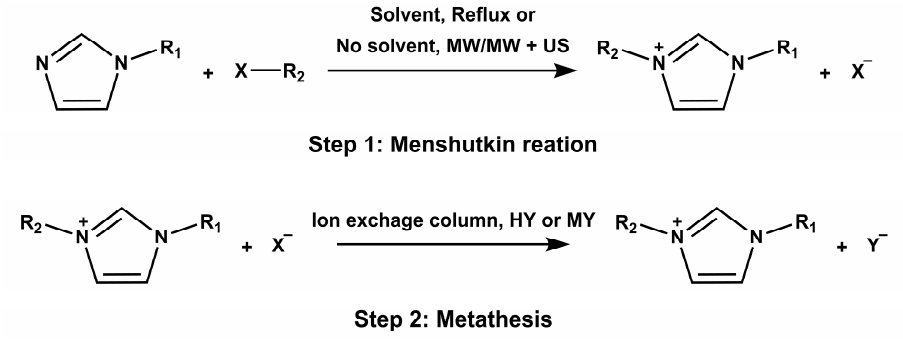
Scheme 1. Schematic representation of the synthesis of ionic liquids and ionic liquid-based surfactants. MW and US refer to microwave and ultrasound irradiation,